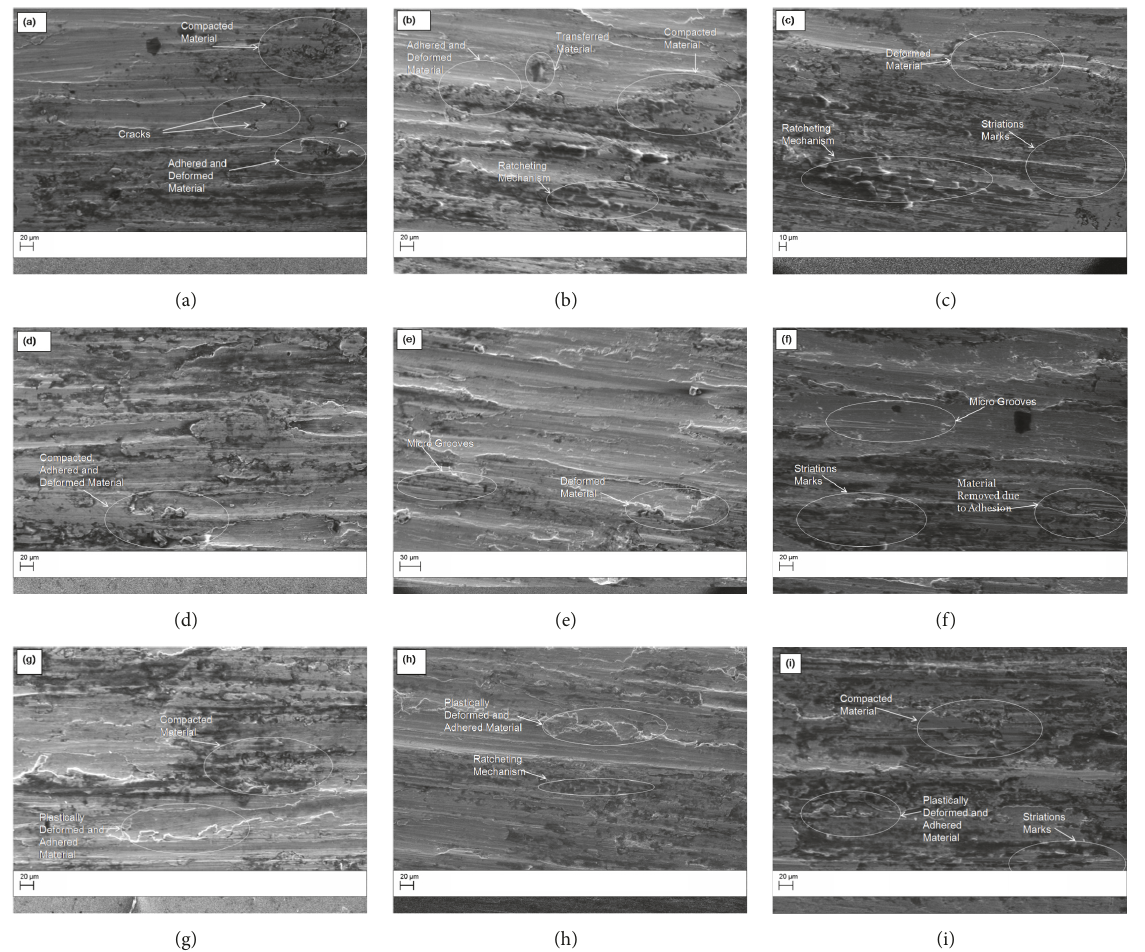
Figure 7: SEM images of worn surfaces of Zircaloy-4 at (a) 0.015 m/s, 475 MPa; (b) 0.015 m/s, 555 MPa; (c) 0.015 m/s, 616 MPa; (d) 0.020 m/s, 475 MPa; (e) 0.020 m/s, 555 MPa; (f) 0.020 m/s, 616 MPa; (g) 0.025 m/s, 475 MPa; (h) 0.025 m/s, 555 MPa; (i) 0.025 m/s, 616 MPa.